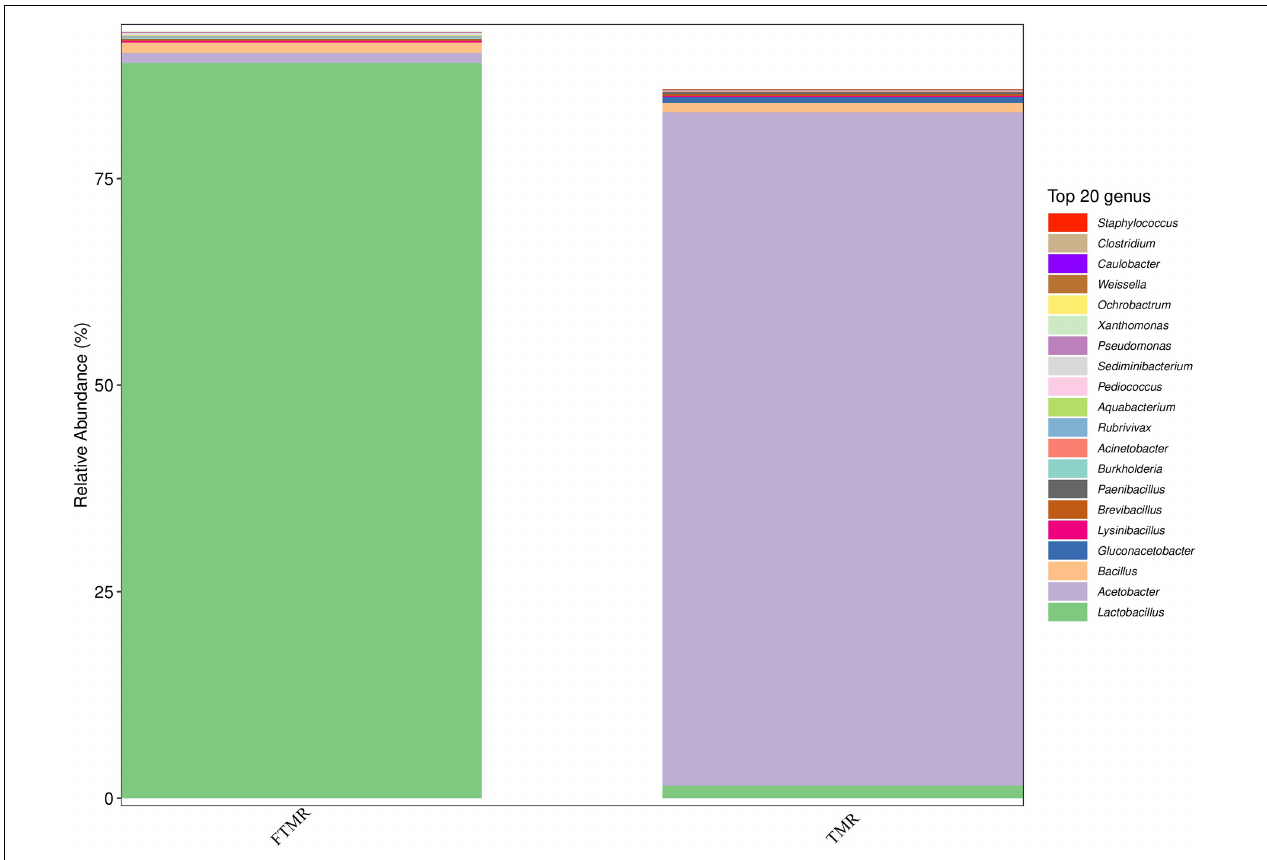
FIGURE 1 | Relative abundance of bacterial under genera level in fermented or non-fermented TMR.